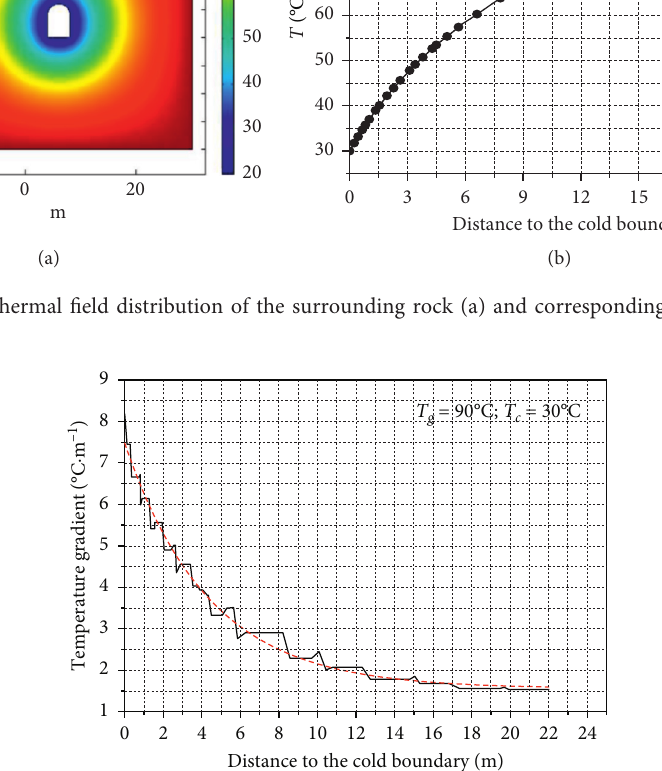
Figure 7: The variation in the temperature gradient with distance.